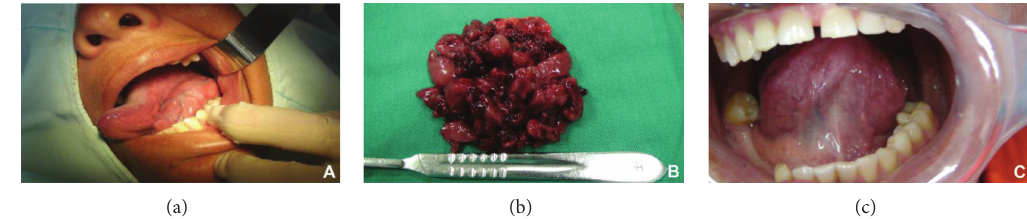
Figure 1: Clinical appearance of the lesion. Extensive soft tissue mass in the left floor of the mouth (a). Gross specimen revealed lobules of tumor tissue (b). Clinical aspect after surgery (c).